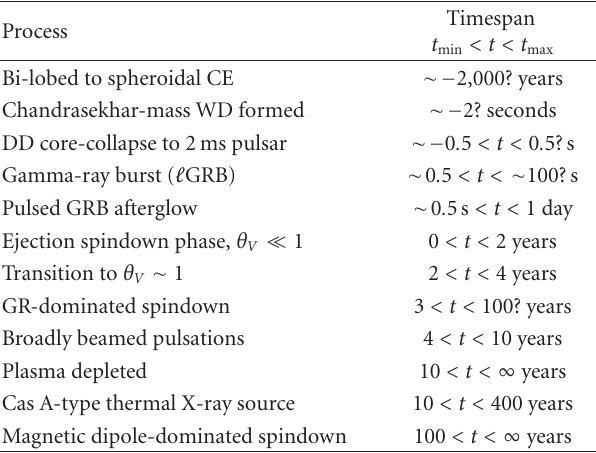
Table 2: 15 M (cid:2) DD-formed pulsar